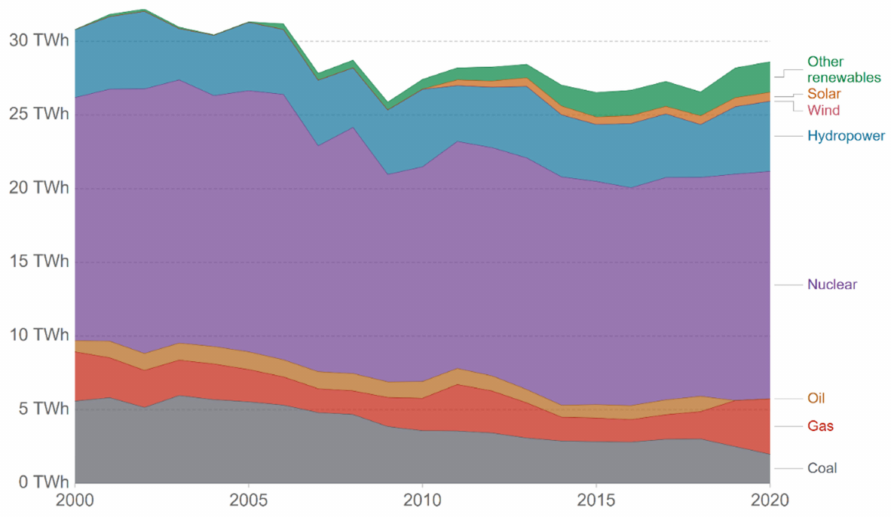
Figure 1. Electricity production by source in Slovakia